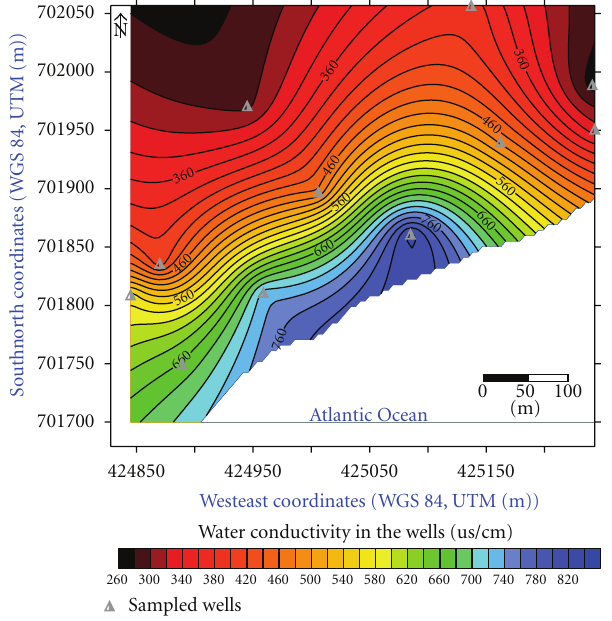
Figure 6: Chart of water